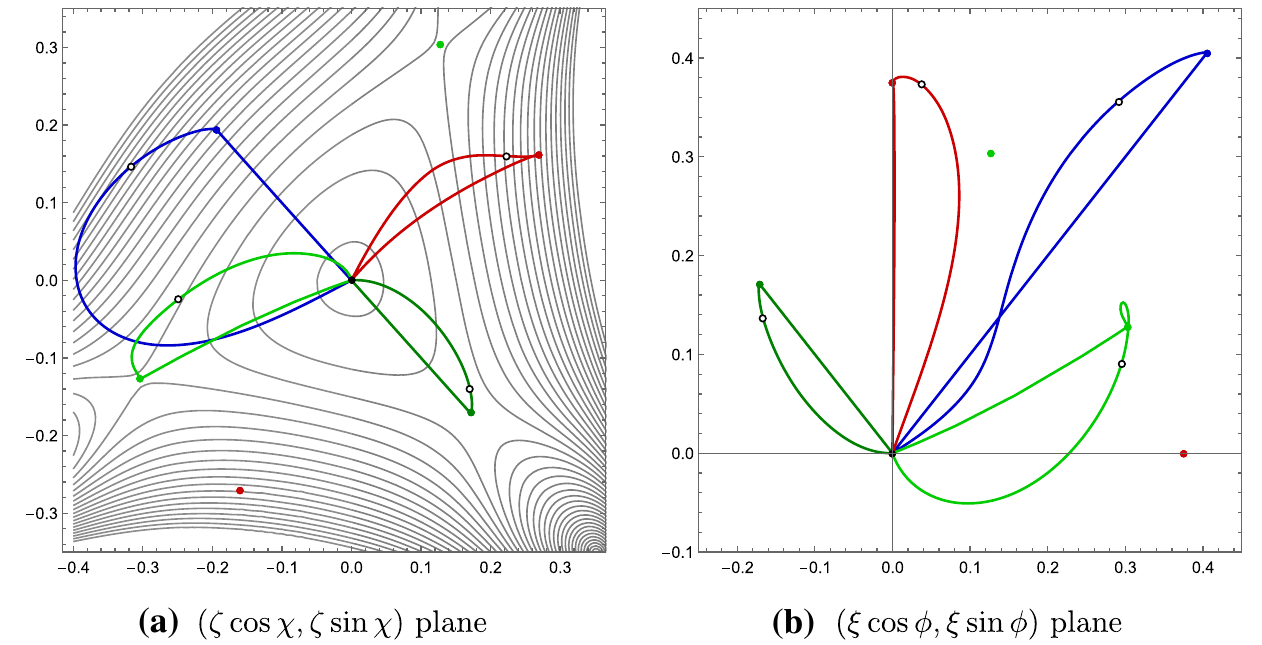
Fig. 9 SO ( 8 )/ SO ( 8 ) and G 2 / G 2 Janus solutions on the contour plot of the superpotential with ω = π respectively